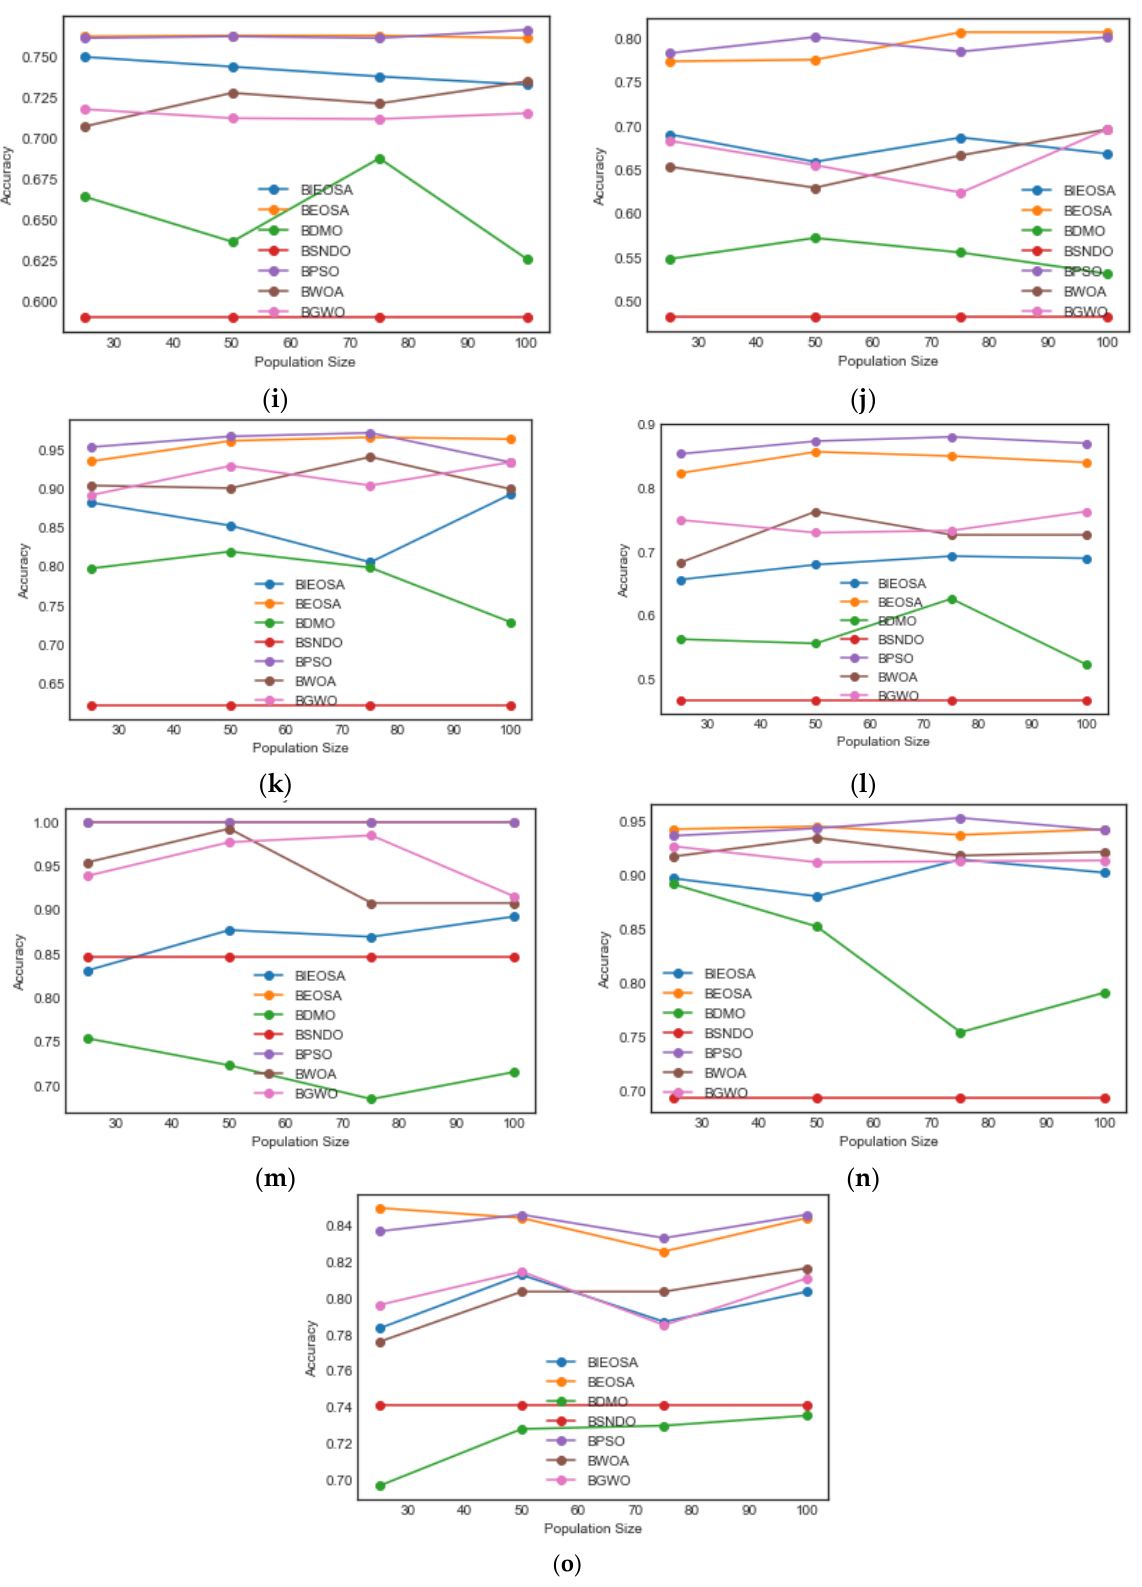
Figure 7. Graph-based comparative analysis of the classification accuracy performance for all binary optimization methods on ( a ) Zoo; ( b ) Vote; ( c ) Wine; ( d ) Sonar; ( e ) Tic-tac-toe; ( f ) M-of-n; ( g ) Ionosphere; ( h ) Exactly; ( i ) Exactly2; ( j ) HeatEW; ( k ) CongressEW; ( l ) Lymphography; ( m ) Colon, ( n ) BreastEW; and ( o ) SpectEW